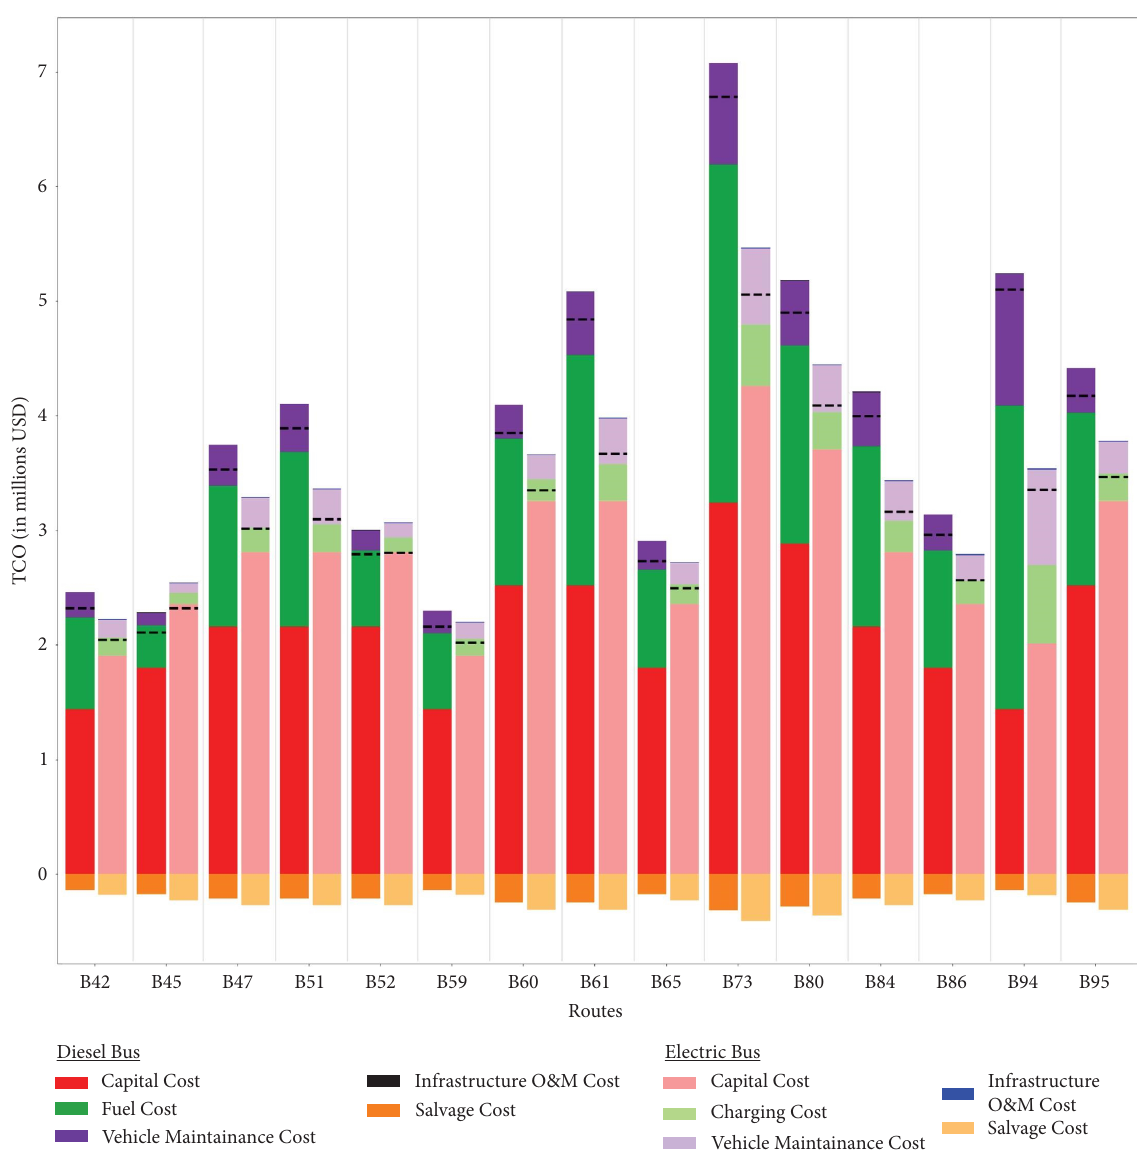
Figure 11: Net present value of the total cost of ownership for